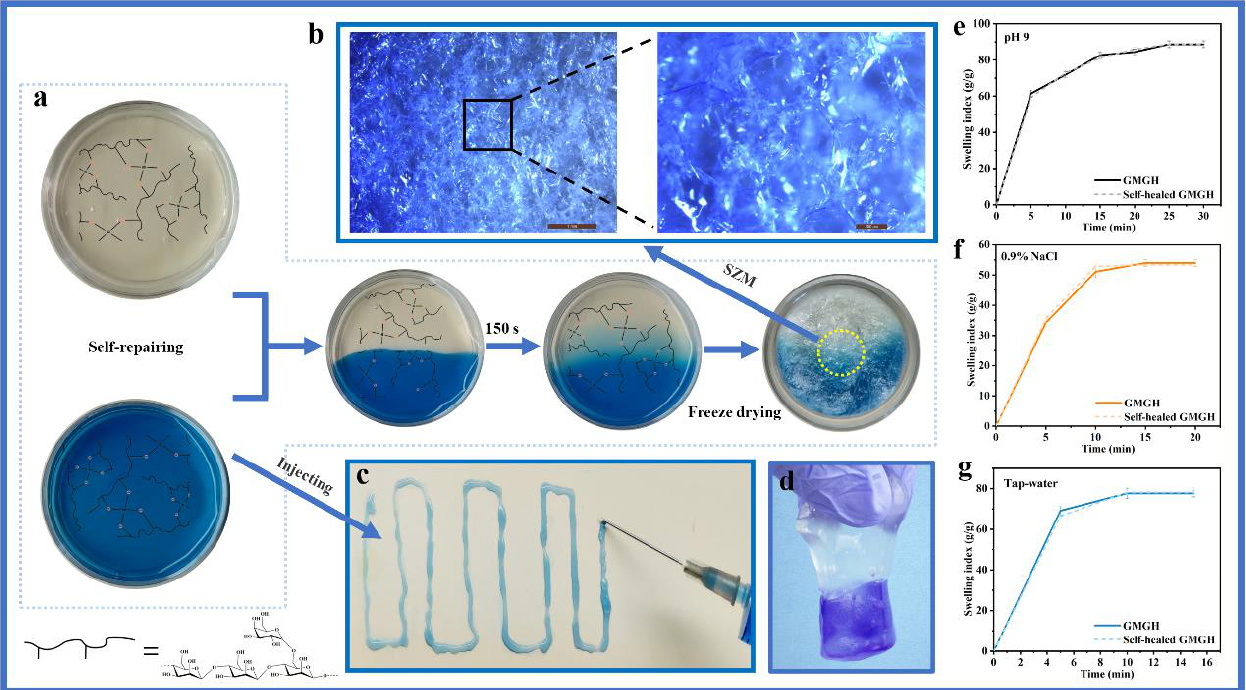
Figure 3. ( a , d ) Photos showing the self-healing behavior of GMGH; ( b ) image of the network pore structure of freeze-dried self-repaired GMGH; ( c ) GMGH can be injected using needles; ( e ) swelling index in water at pH 9; ( f ) Swelling index in 0.9% NaCl solution; ( g ) Swelling index in tap water.